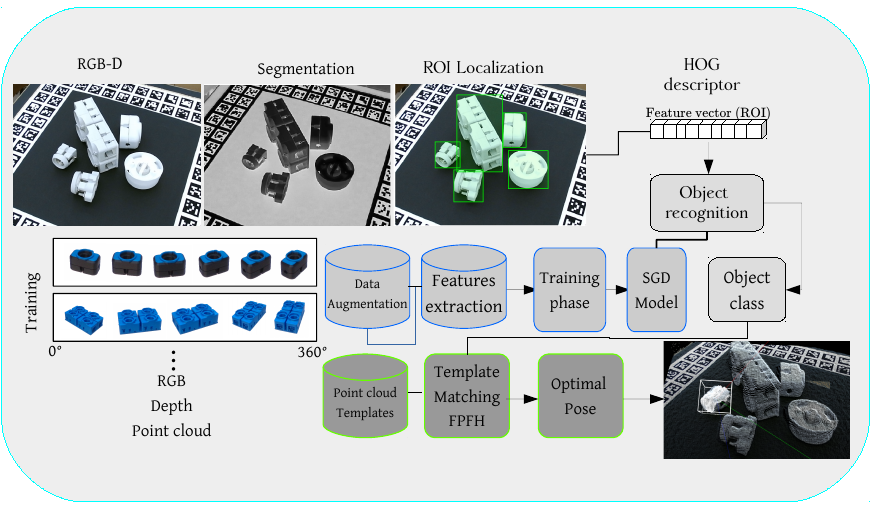
Figure 1. Our object detection and pose estimation pipeline. After object segmentation and localisation (RGB image), each Region of Interest (ROI) is cropped and normalised. HOG features are extracted and forwarded into the SGD object recognition model. After object recognition, we generate the point cloud of the object using both depth and RGB image. We adapt a point cloud matching strategy using the Fast Point Feature Histograms (FPFH) descriptor to find the target object’s optimal pose in our database.